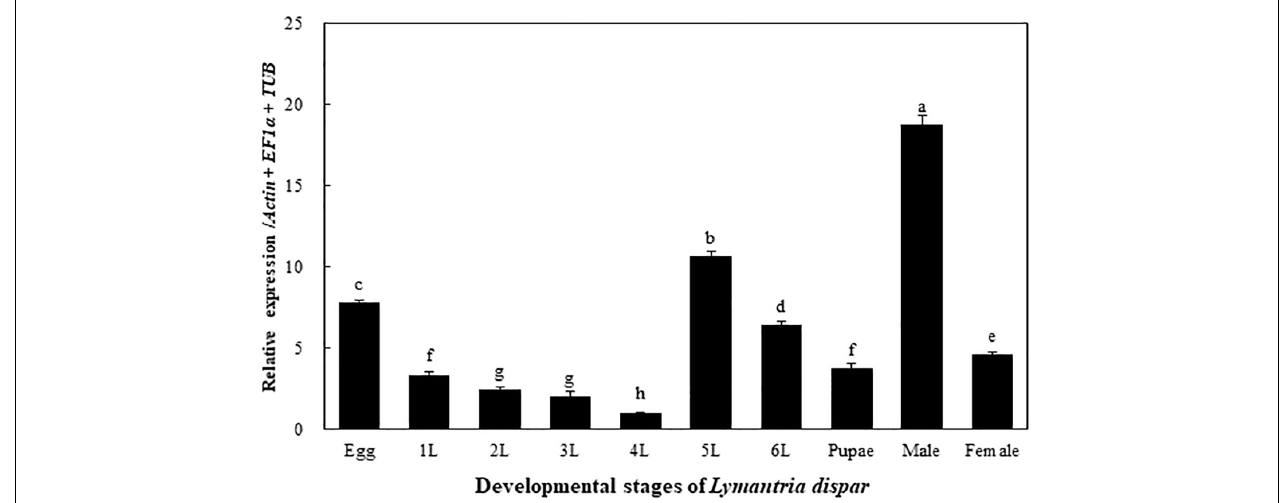
FIGURE 1 | Transcriptional expression of the LdOA1 gene during different developmental stages of L. dispar . 1 to 6 L represent 1st to 6 th instar L. dispar larvae. Data were normalized to three most stable reference genes Actin , EF1 α , and TUB . The 2 − (cid:49)(cid:49) CT method was used to calculate relative expression levels. The expression was shown as mean ± SD from three independent assays. Different lowercase letters above bars indicate significant difference among developmental stages according to ANOVA followed by Student-Newman-Keuls multiple comparisons test ( P < 0.05).